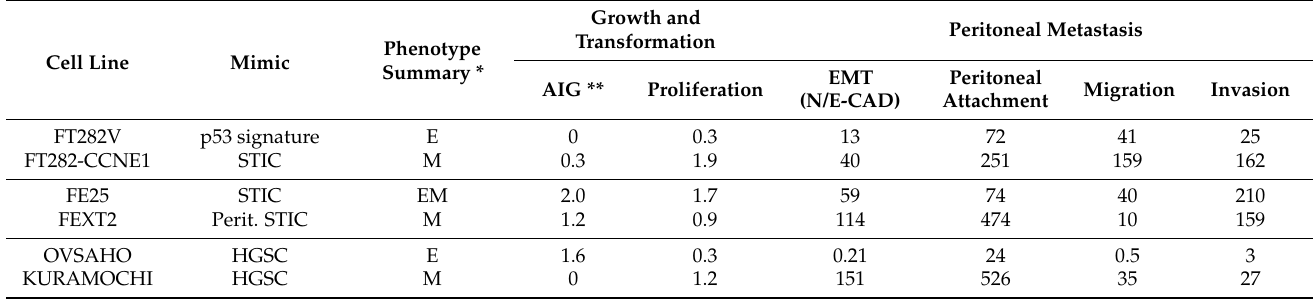
Table 2. Transition of the epithelial (E) and mesenchymal (M) phenotypes in FTE transformation and in HGSC.